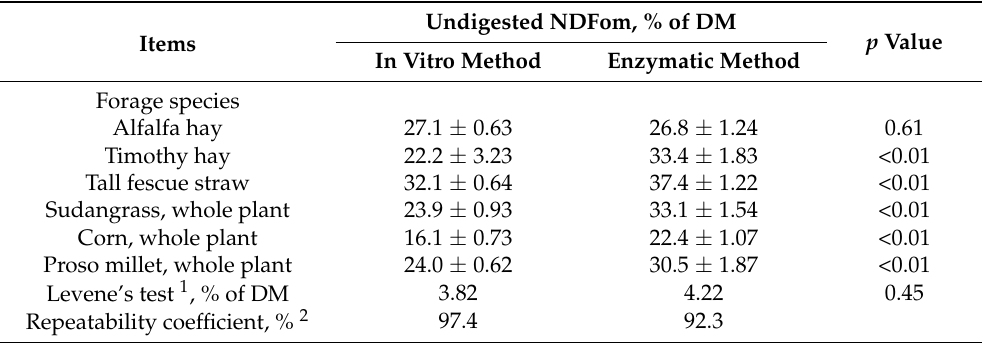
Table 2. Precision parameters associated with undigested NDF determination in various forages by the in vitro method versus enzymatic method (experiment